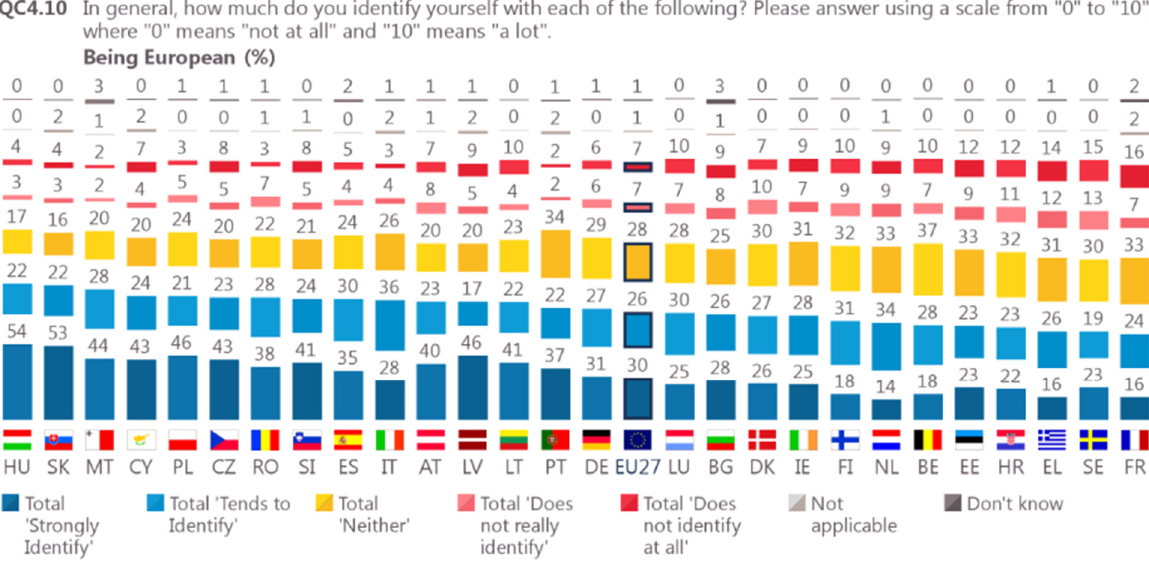
Figure 2. Identifying as European according to the special Eurobarometer 508 [26].